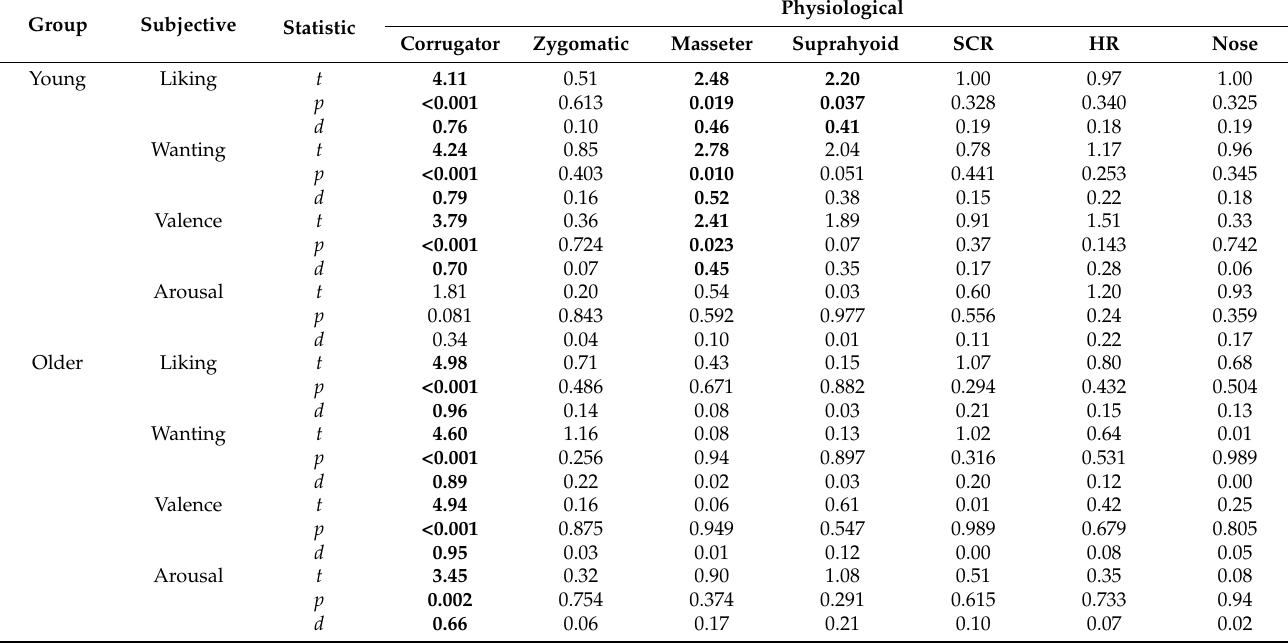
Table 1. Results of one-sample t -tests (vs. 0; two-tailed) for subjective-physiological coherence in young and older